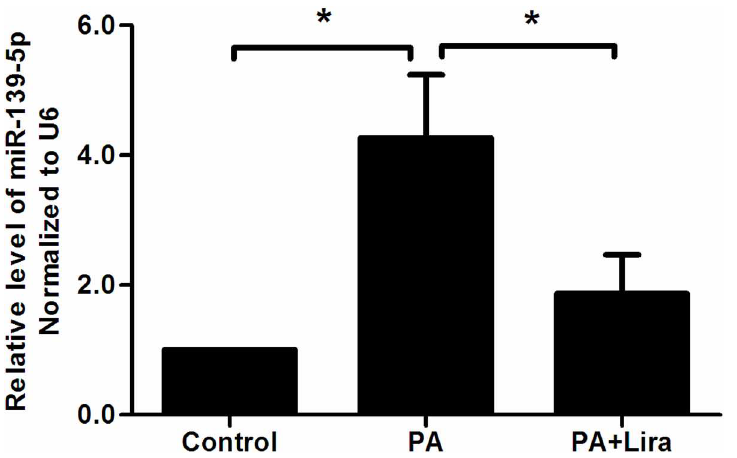
Fig 7. MiR-139-5p expression in INS-1 cells treated with palmitic acid (PA) and palmitic acid + liraglutide (PA+Liar) (n = 3, * p < 0.05). Cells were dividedinto control, PA and PA+Lira group, which respectivelytreated with vehicle, palmitic acid (0.5nmol/L)or palmitic acid (0.5mmol/L) + liraglutide(100nmol/ L) for 48 h.